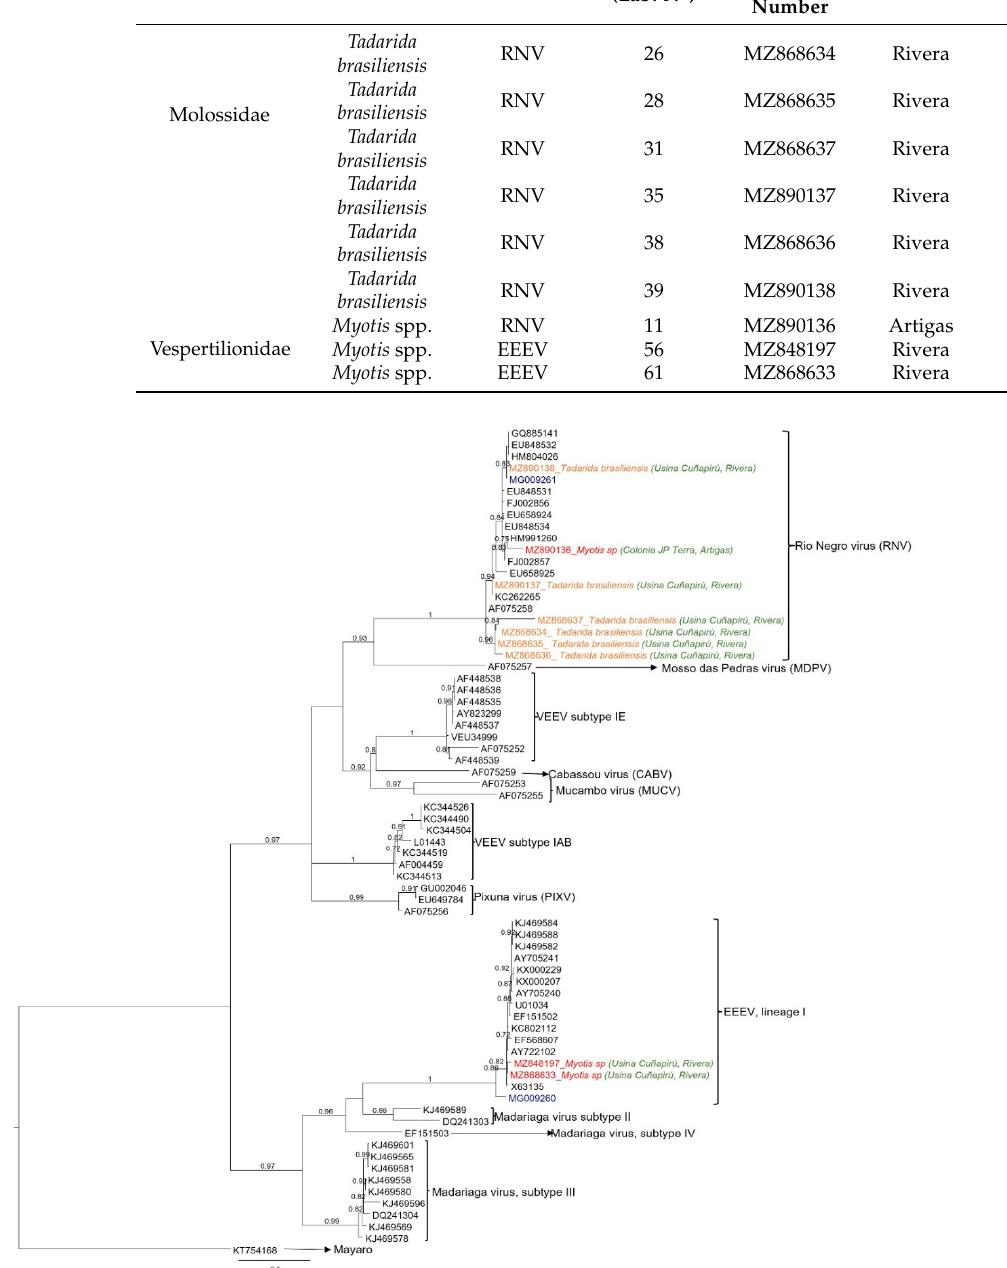
Figure 2. Maximum likelihood phylogenetic tree based on partial nsP4 sequences. For comparison, sixty-two alphavirus sequences from different species were downloaded from GenBank, including the mosquito sequences previously reported in Uruguay (blue). Phylogeny was reconstructed under the GTR + Γ + I nucleotide substitution model. Mayaro virus was used as outgroup species. Clade supports were estimated through approximate likelihood ratio test (aLRT), and only those above 0.70 are shown. Accession numbers, bat species, and capture localities of the nine alphaviruses detected in this work are depicted in color: viruses found in Tadarida brasiliensis : orange; viruses found in Myotis spp . : red; capture sites: green; RNV and EEEV positive mosquitoes from Uruguay: blue.